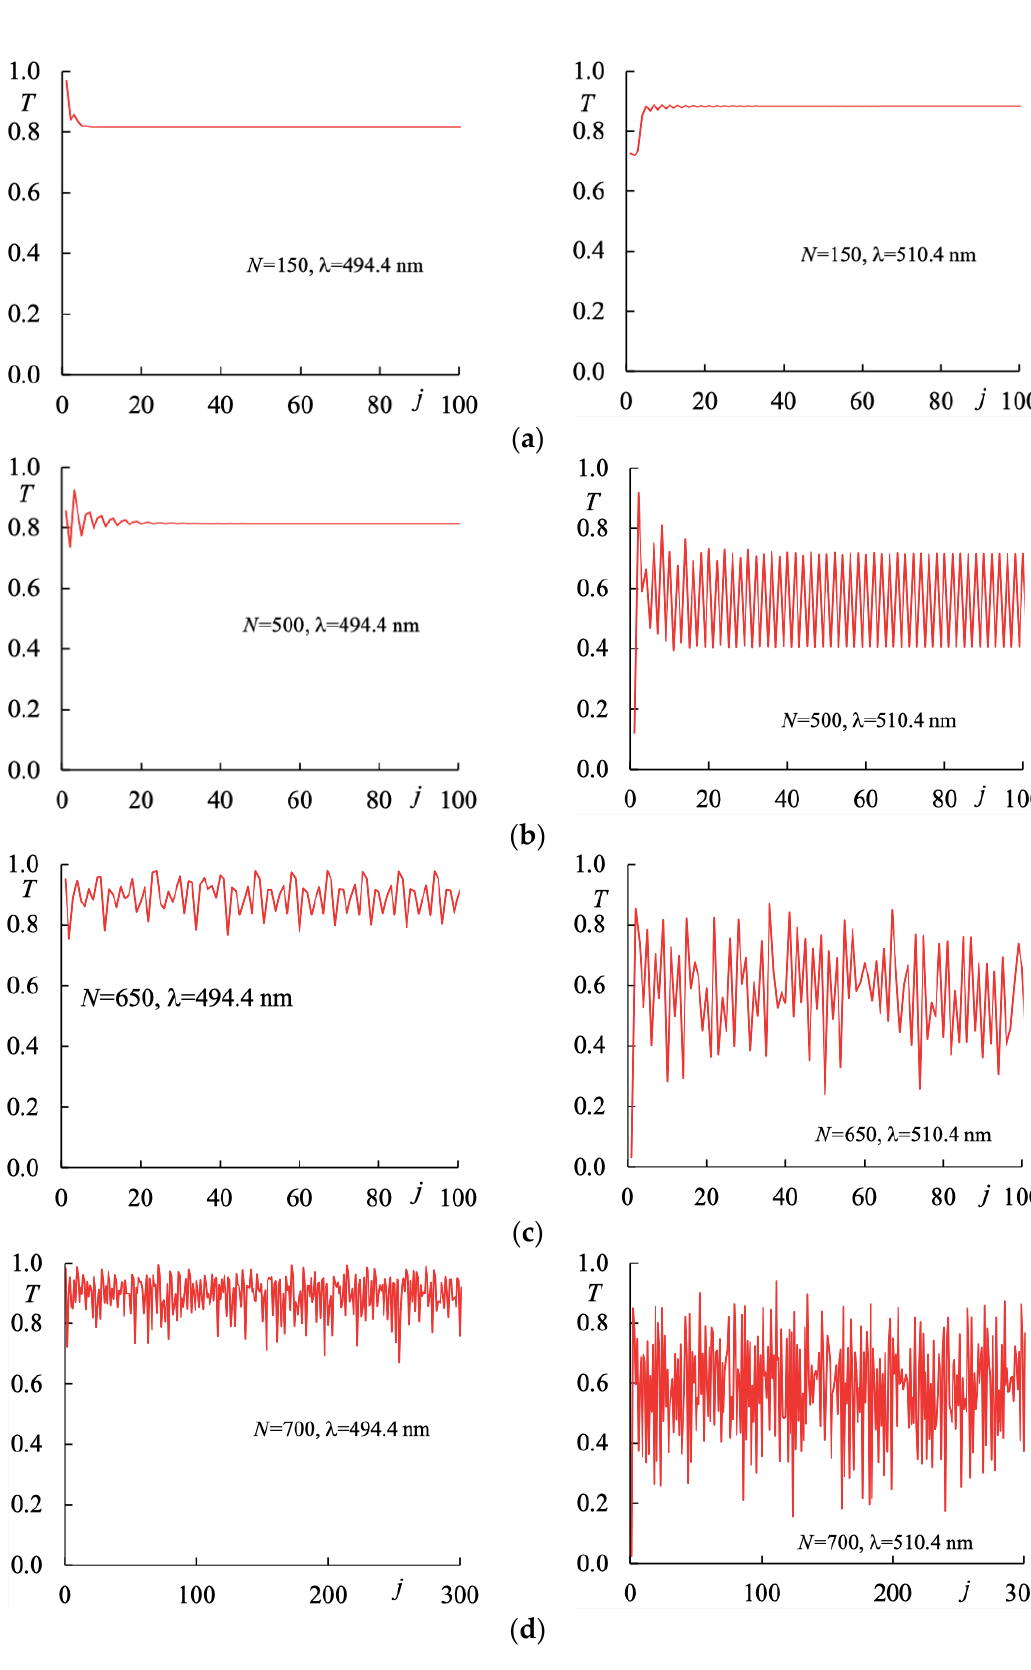
Figure 3. The transmittivity vs. the index j for two wavelengths λ 1 = 494.4 nm and λ 2 = 510.4 nm symmetric with respect to the Bragg peak λ B = 502.4 nm at increasing values of the normalized intensity N . ( a ) N = 150; ( b ) N = 500; ( c ) N = 650; ( d ) N =